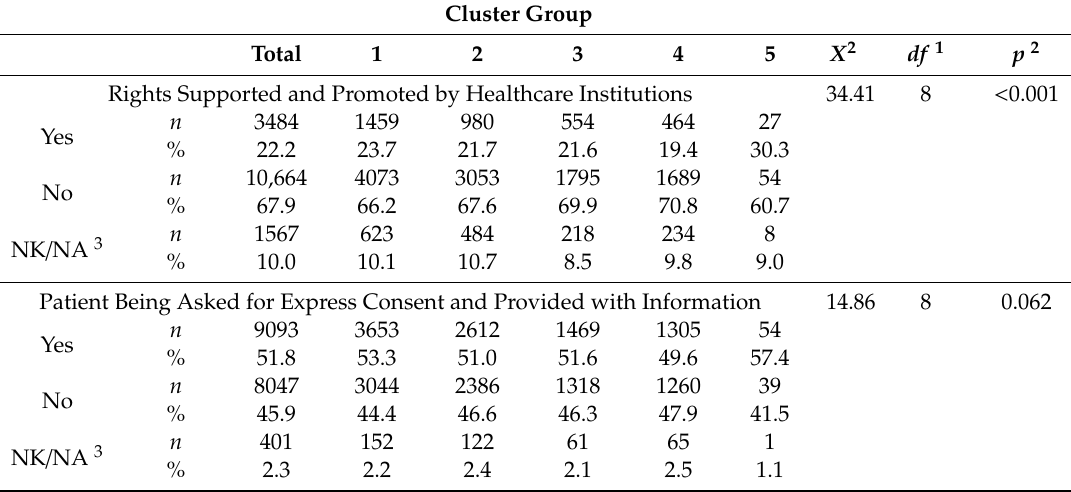
Table 3. The bivariate results of the variables related to health professionals’